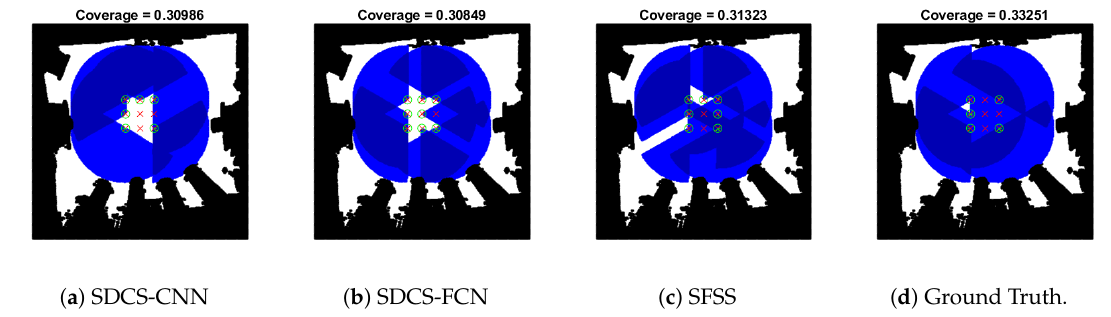
Figure 13. Coverage area is shown in Map-0 with Figure 12a. The black and white grids represent the occupied and unoccupied grids, respectively. The blue grids represent the coverage area of the sensor. The grid being dark blue means that this grid is covered by at least two sensors. The green circle and red cross represent the subgoal being selected or not.